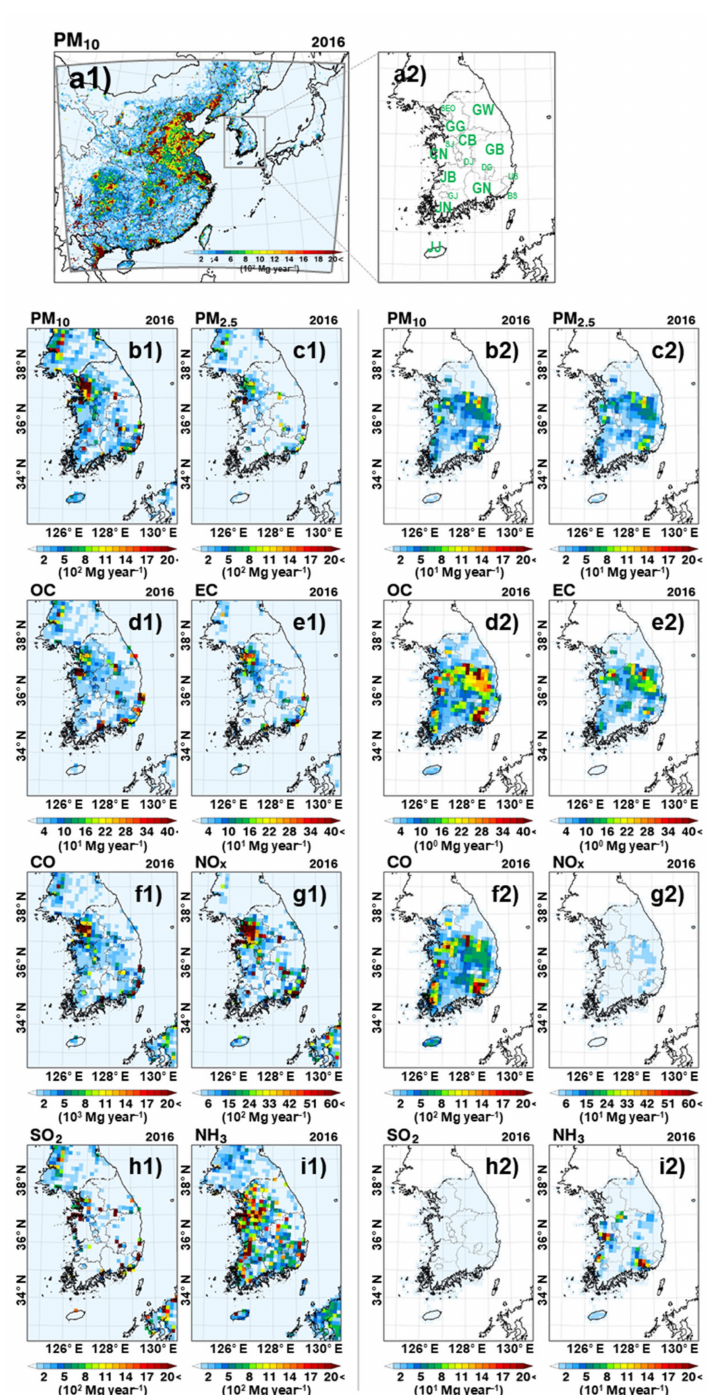
Figure 3. ( a1 ) Study domain and annual emission fluxes over South Korea for ( b1 ) PM 10 , ( c1 ) PM 2.5 , ( d1 ) OC, ( e1 ) EC, ( f1 ) CO, ( g1 ) NO x (as NO), ( h1 ) SO 2 , and ( i1 ) NH 3 combined from the CAPSS, MEGAN, and FINN v1.5 inventories used in the SM1 simulations (in the left two columns). ( b2 – i2 ) Annual emission fluxes for the same species from the residue burning of 19 crops used in the SM2 simulation (in the right two columns). The units are small by a factor of 0.1 than those of the same species on the left columns. ( a2 ) Administrative district of Seoul (SEO), BS (Busan), DG (Daegu), IC (Incheon), GJ (Gwangju), DJ (Daejeon), US (Ulsan), SJ (Sejong), GG (Gyeounggi), GW (Gangwon), CB (Chungbuk), CN (Chungnam), JB (Jeonbuk), JN (Jeonnam), GB (Gyeongbuk), GN (Gyeongnam), and JJ